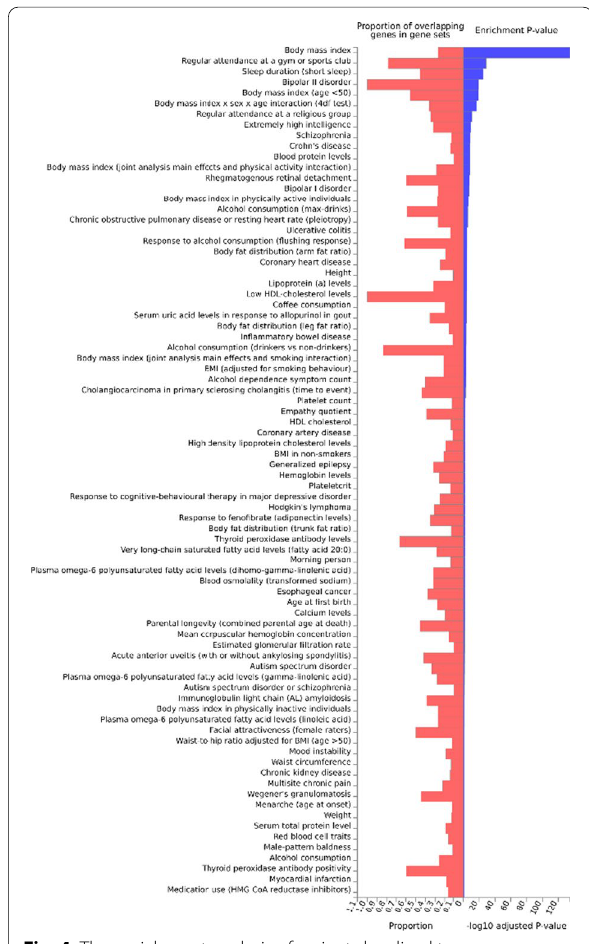
Fig. 4 The enrichment analysis of variants localized to genes associated with GWG among those associated with BMI in the GIANT